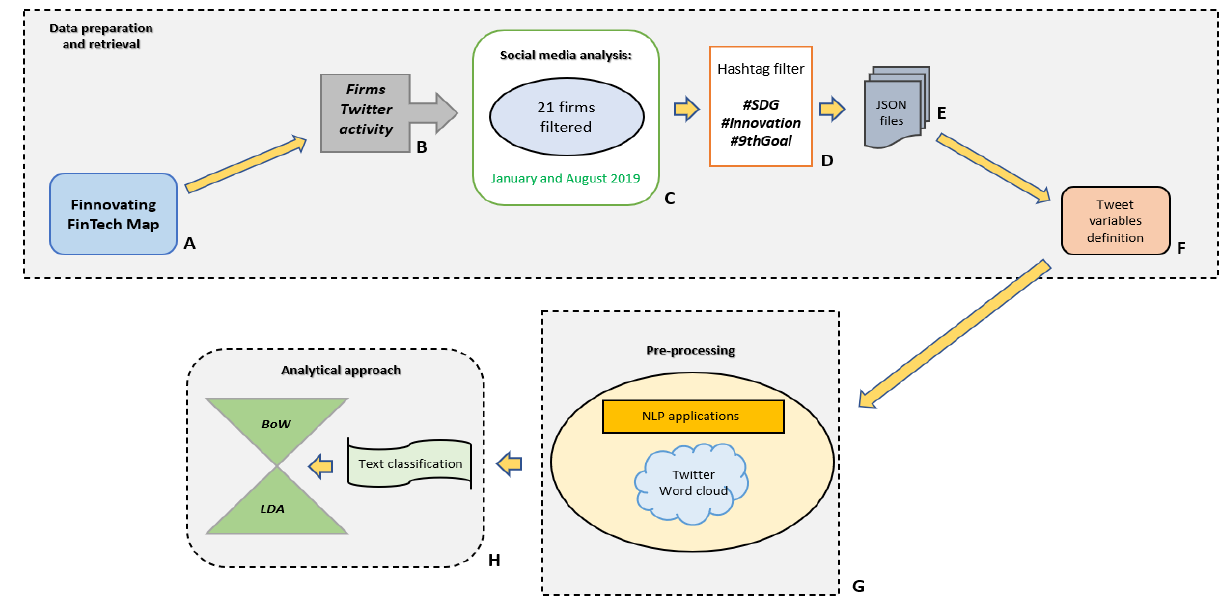
Figure 1. Overview of the methodology. The steps ( A – H ) described in this Figure are detailed along the Methodological Framework section.